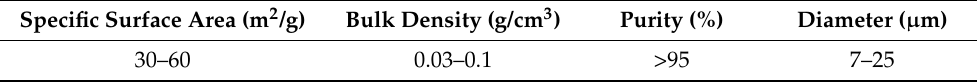
Table 1. Properties of